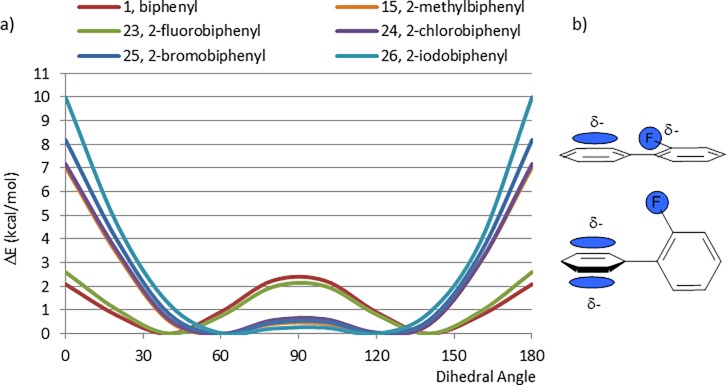
a) CEPs of a series of 2-halobiphenyls (23–26) and comparison with biphenyl 1 and 2-methylbiphenyl 15; b) Electrostatic fluorine—pi cloud aromatic ring attraction and repulsion.